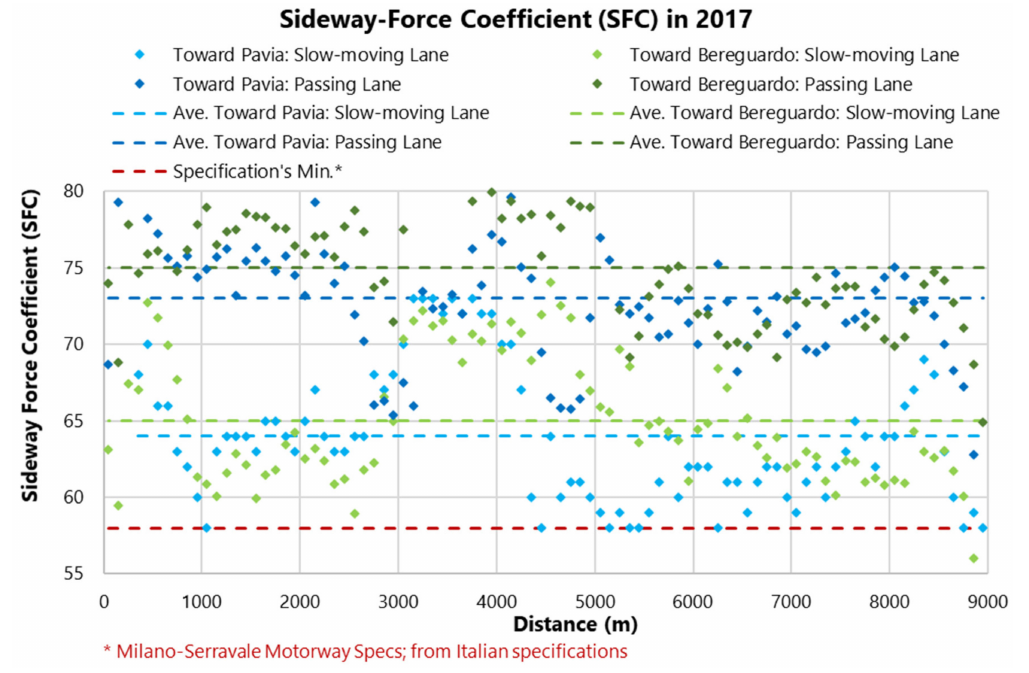
Figure 12. Sideway-force coefficient (SFC) in 2017.